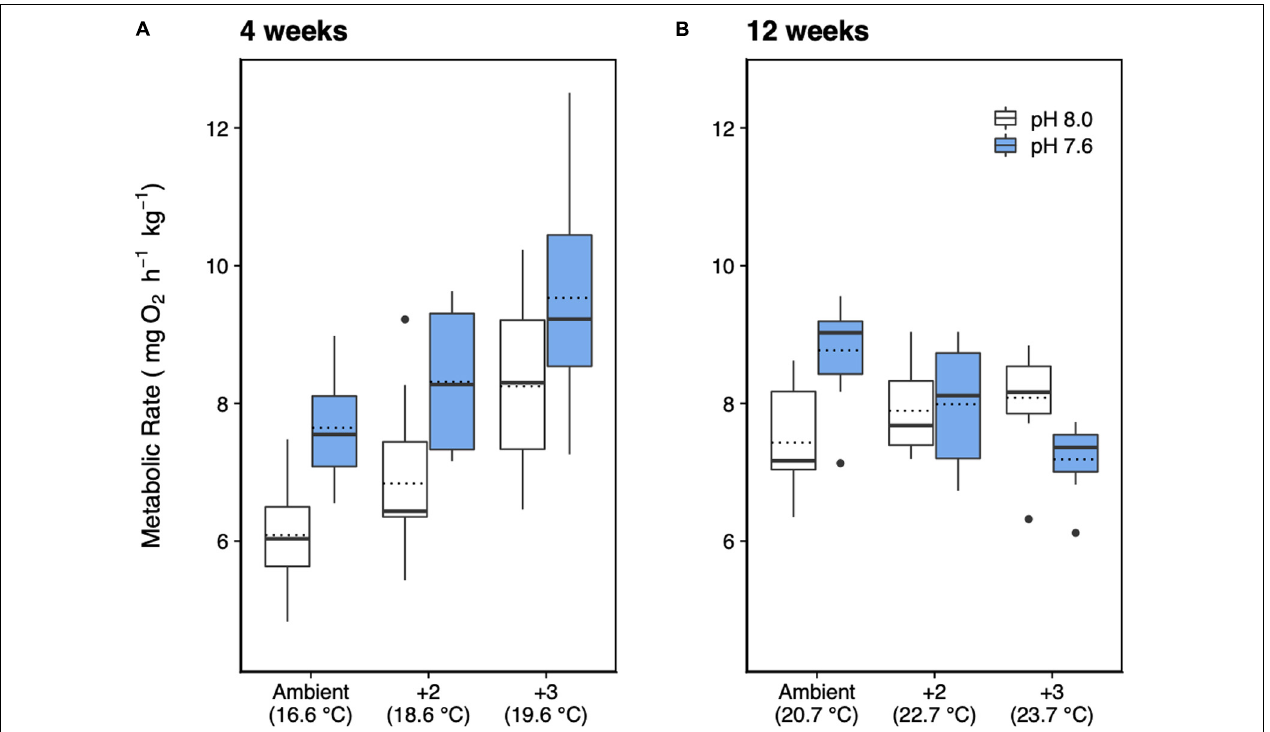
FIGURE 3 | Metabolic rate of H. erythrogramma acclimated for (A) 4 and (B) 12 weeks in three temperature (ambient, +2 ◦ C, +3 ◦ C) and two pH T (white: 8.0, blue: 7.6) levels in six treatments. The top and bottom of the boxes represent the interquartile range (IQR) between the 25th and 75th percentile (Q1 and Q3, respectively). The horizontal line represents the median (Q2), the horizontal dotted line represents the mean, and the vertical lines (whiskers) represent the range of the data computed as follows: less than Q1 – 1.5 IQR (bottom whisker); greater than Q3 + 1.5 IQR (top